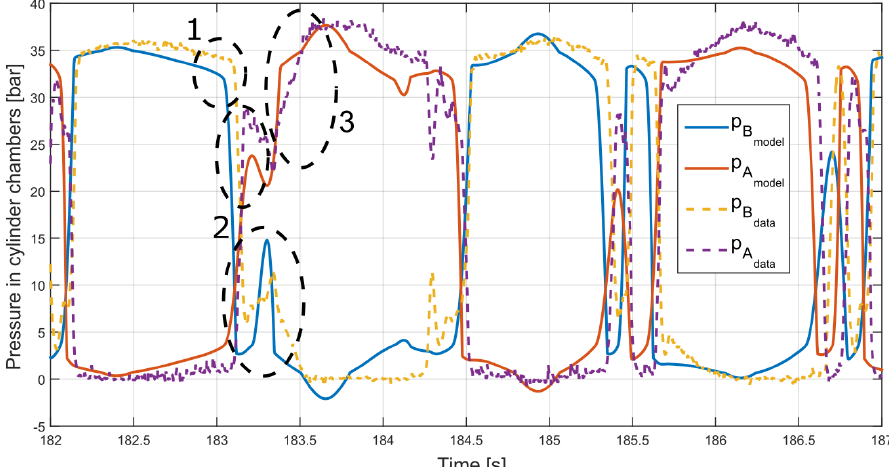
Figure 13. Pressure in the chambers A and B of the hydraulic cylinder from the experiments and the mathematical model for the constant-pressure